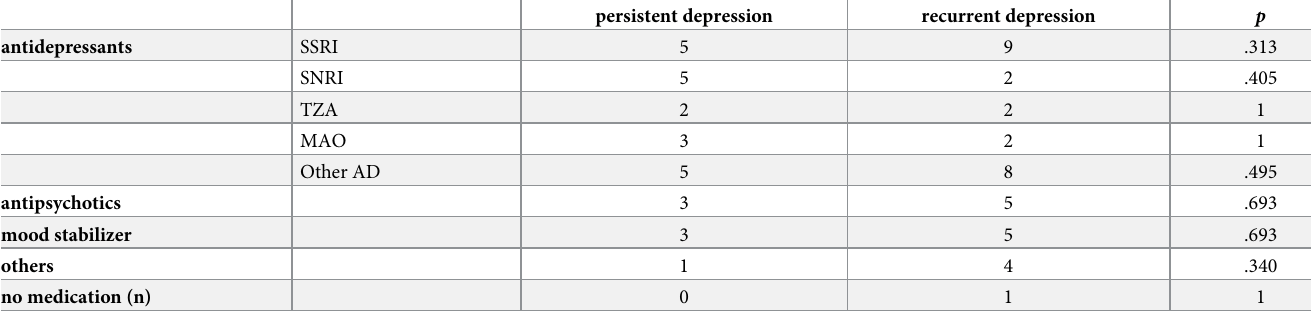
Table 1. Frequencies of psychiatric